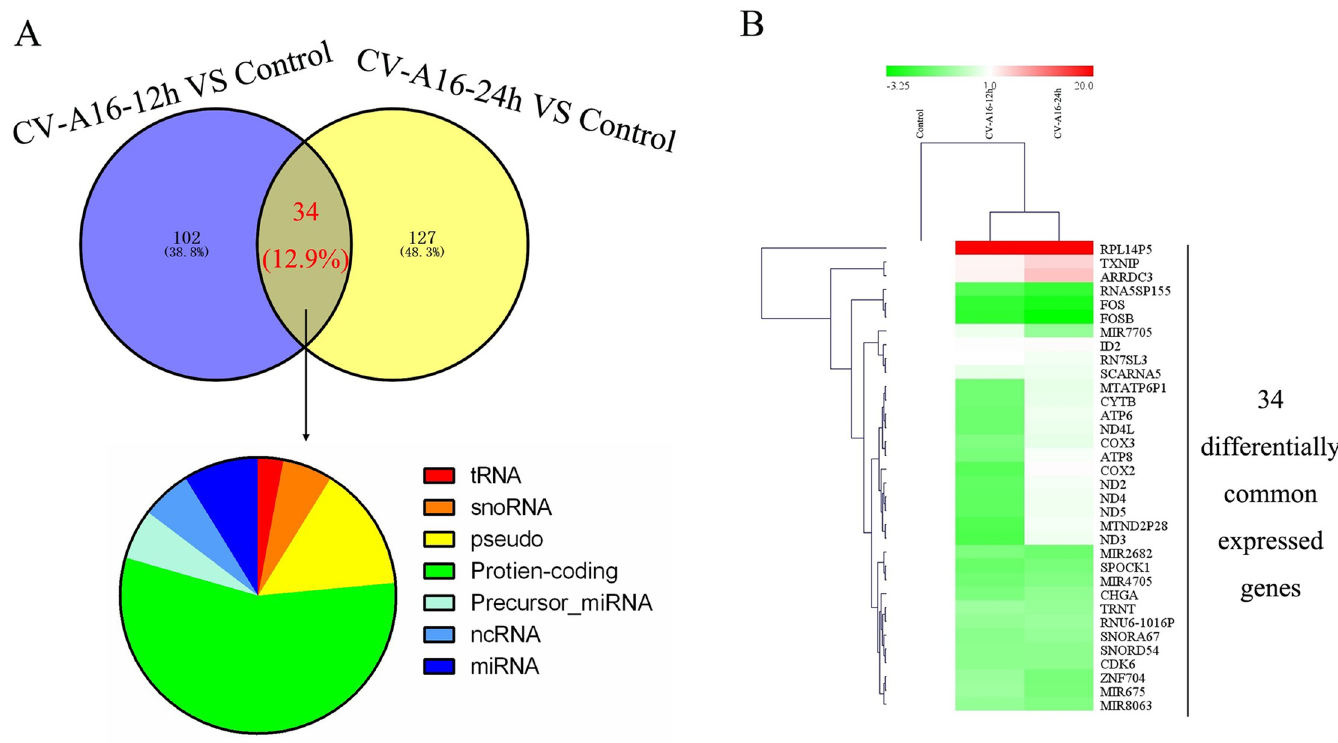
Fig 2. (A) Venn diagram analysis showing a total of 34 differentially expressed genes under different conditions. (B) Heat-map showing the increased (red) or decreased (green) expression trends of common differentially expressed genes during CV-A16